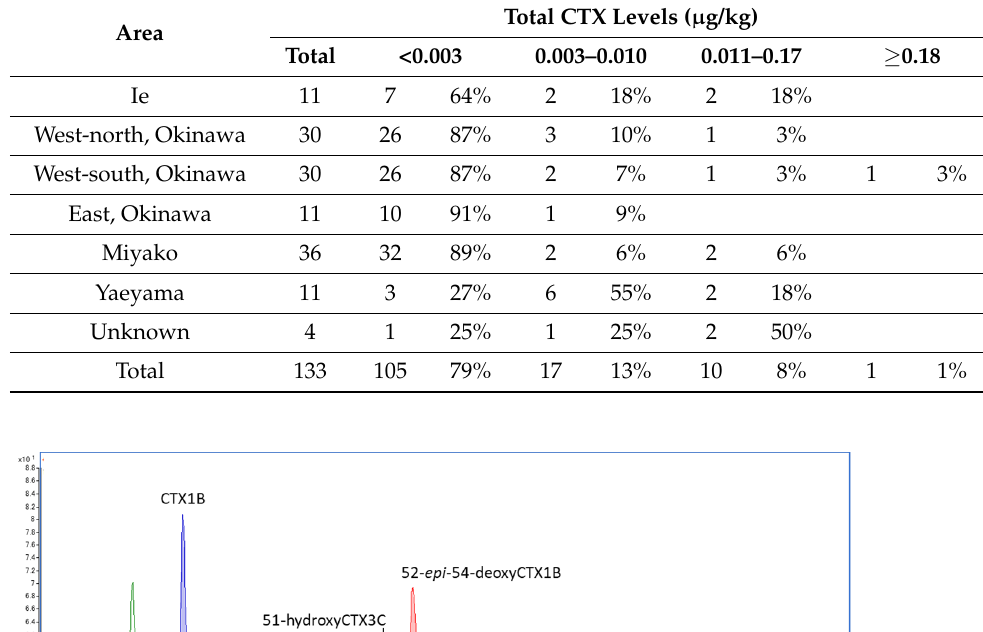
Table 1. The CTX levels in the flesh samples of grouper V. albimarginata collected off Okinawa, Japan.